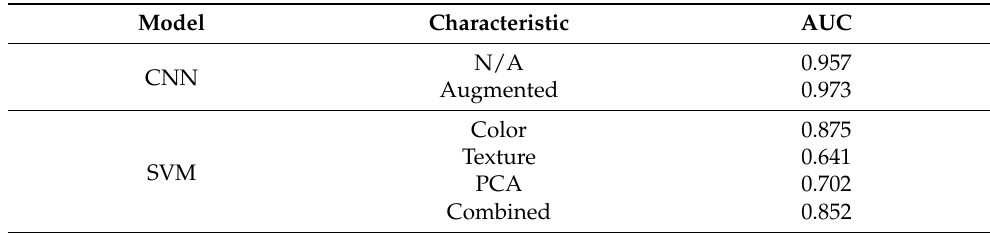
Table 4. Comparative matrix of results of the classifiers—ROC